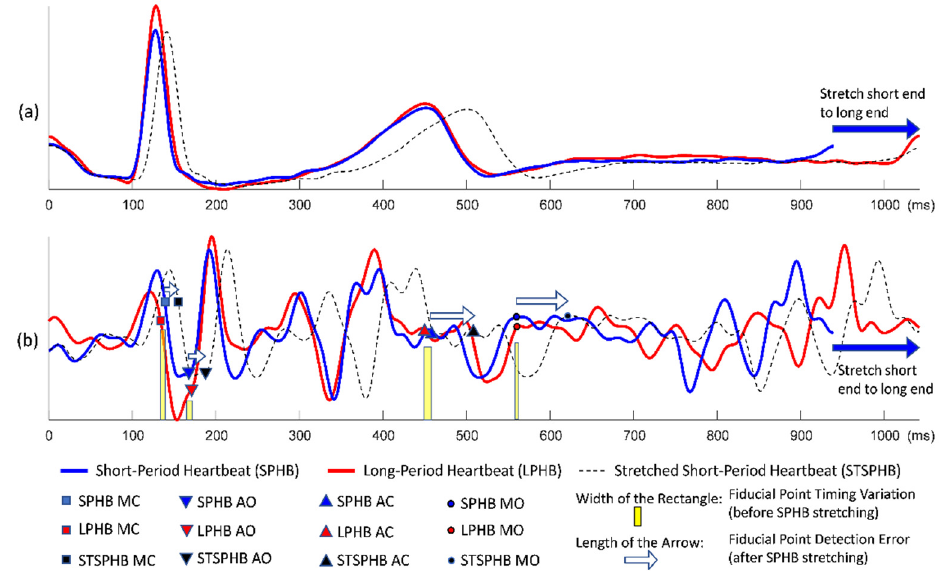
Figure 2. Conventional quasi-synchronous alignment by stretching the short-period signal: ( a ) Long-period (red), short-period (blue), and stretched short-period (black dashed) ECG signals; ( b ) Long-period (red), short-period (blue), and stretched short-period (black dashed) SCG signals with fiducial points and the detection error indicators (white arrows).